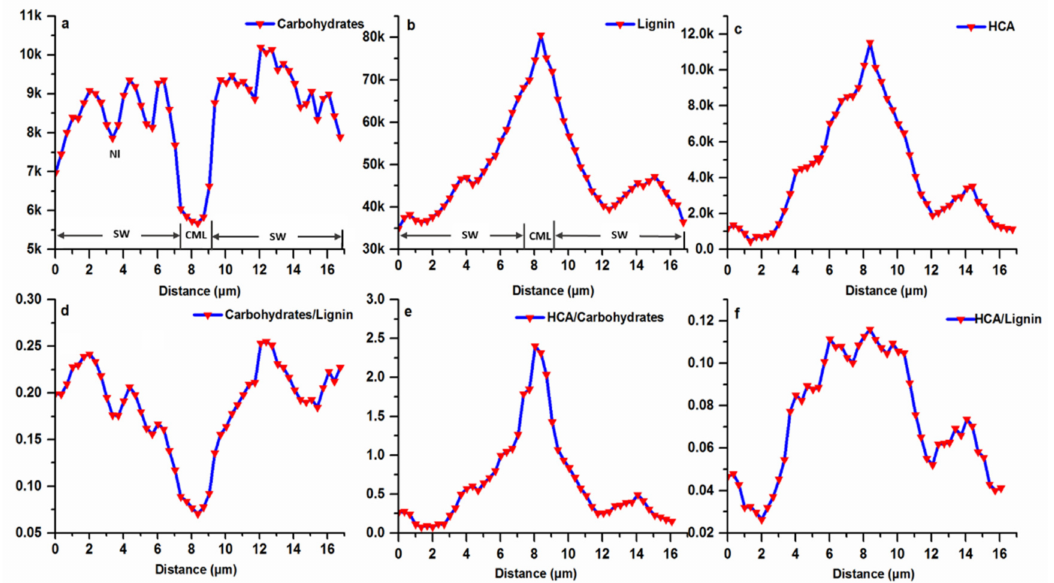
Figure 5. Raman line scan of Bg fiber wall, ( a ) Carbohydrates; ( b ) Lignin; ( c ) HCA; ( d ) Carbohydrates to lignin ratio; ( e ) HCA to carbohydrates ratio; ( f ) HCA to lignin